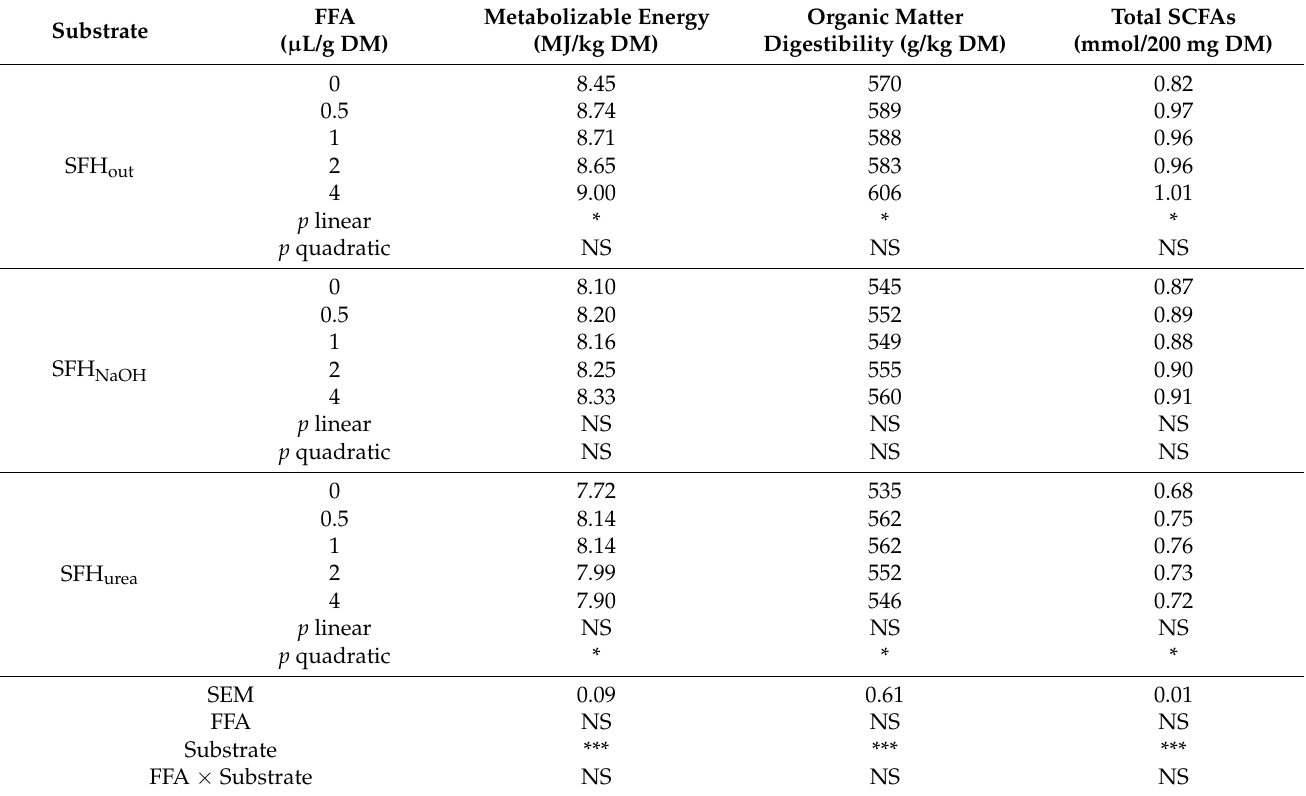
Effects of FFA supplemented to pretreated SFH (SFH out , SFH NaOH , SFH urea ) on metabolizable energy, organic matter digestibility and ruminal total short chain fatty acids concentrations (SCFAs).